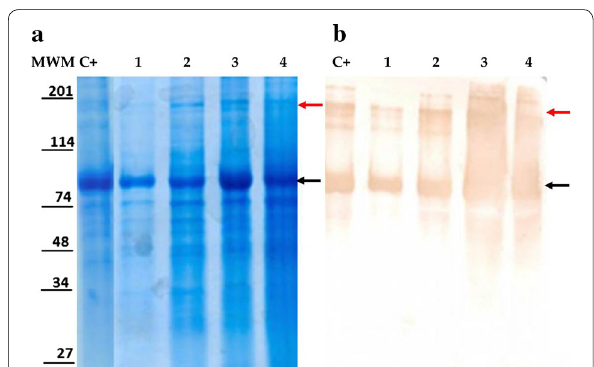
Fig. 3 Analysis of the E2‑CD154.1 and E2‑CD154.2 proteins obtained in the experimental production processes in a 10 L fermenter a SDS‑PAGE 10% under reducing conditions, b Western blotting using MAb2.3HRP monoclonal antibody 1:5000. MWM: Molecular weight marker; C : Positive control of E2‑CD154 (Suárez et al. 2017); 1 and 2: + 10 µL of the batch 1 and batch 2 supernatants respectively applied directly. 3 and 4: 1 mL of the batch 1 and batch 2 supernatants respectively concentrated by precipitation. The black arrows indicate the probable E2‑CD154 monomer and the red arrows pointed the putative E2‑CD154 dimers and aggregates with high molecular